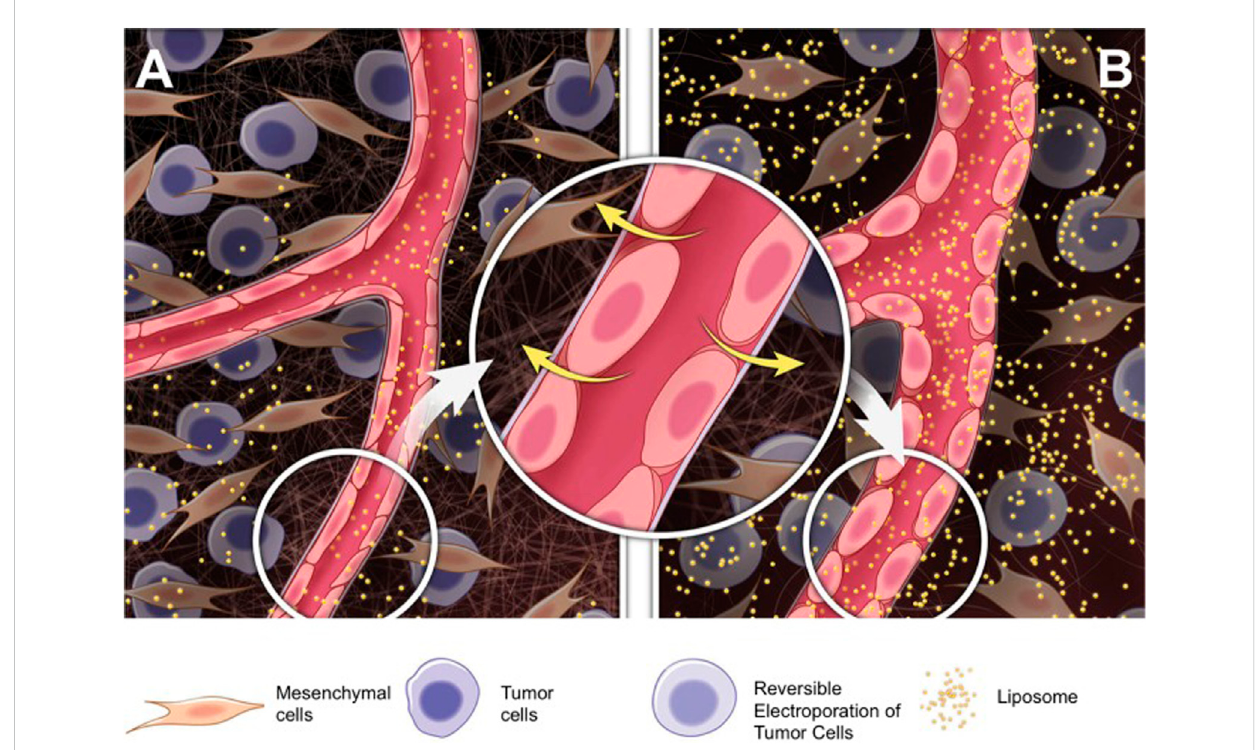
FIGURE 6 Mechanisms underlyingthepromotionofRE-associatedvasculareffectsonliposomalnanoparticledelivery.Comparedto (A) Untreatedtumors, (B) RE induces rounding of endothelial cells and penetration of nanoparticles into treated tumors. RE, reversible electroporation (Srimathveeravalli et al., 2018). Copyright © 2018,